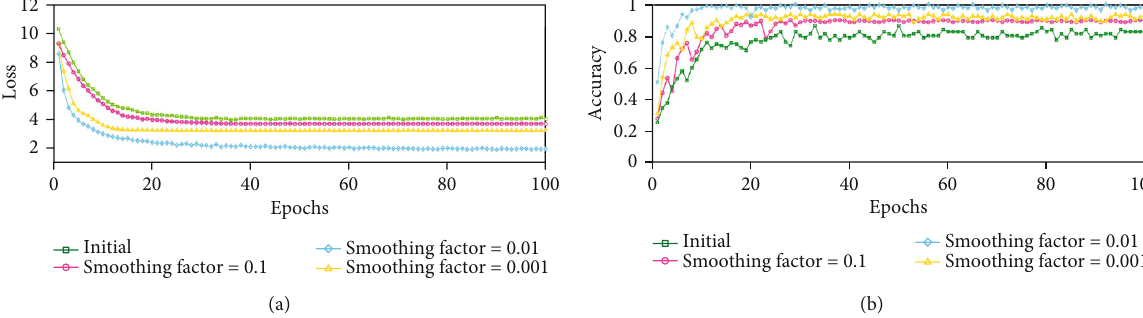
Figure 5: Training and validation curve before and after label smoothing. (a) Model loss on the training set. (b) Model accuracy on the validation set.